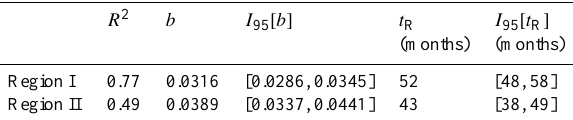
Table 1. Values of R-squared ( R 2 ), estimates ( b ) and 95% confi- dence intervals ( I 95 [ b ]) of parameter b , and estimates ( t R ) and 95% confidence intervals ( I 95 [ t R ] ) of recovery time respecting to the fit by linear regression of the monoparametric model of vegetation re- covery, given by Eq. (5), in Regions I and II.